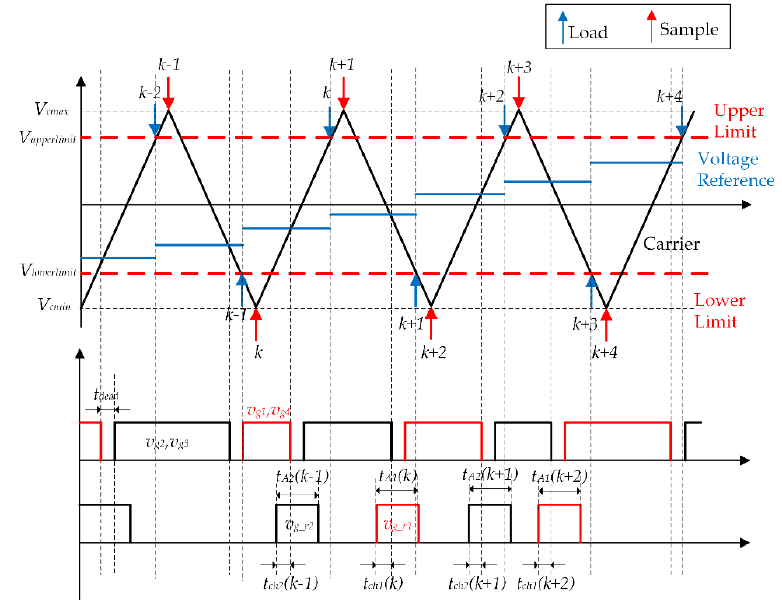
Figure 4. Digital pulse ‐ width ‐ modulation (DPWM) diagram of the ARSI.